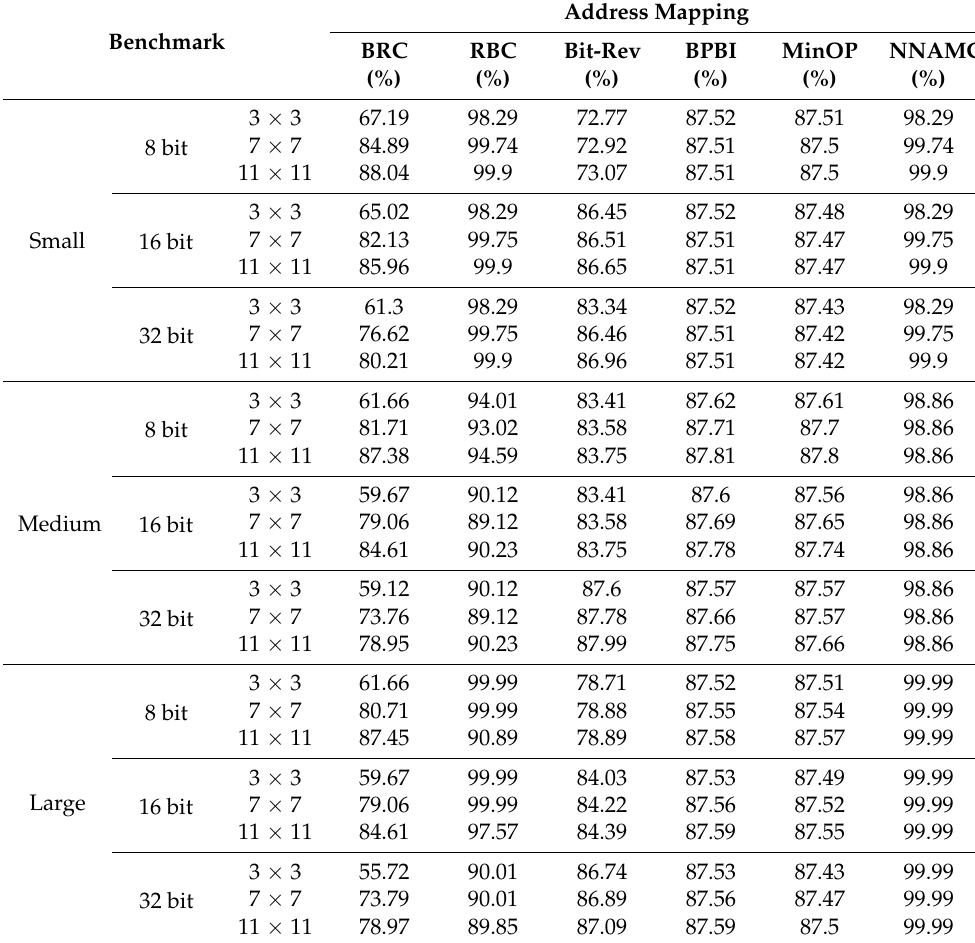
Table 3. Row buffer hit ratios of different address mappings during many convolution operations.